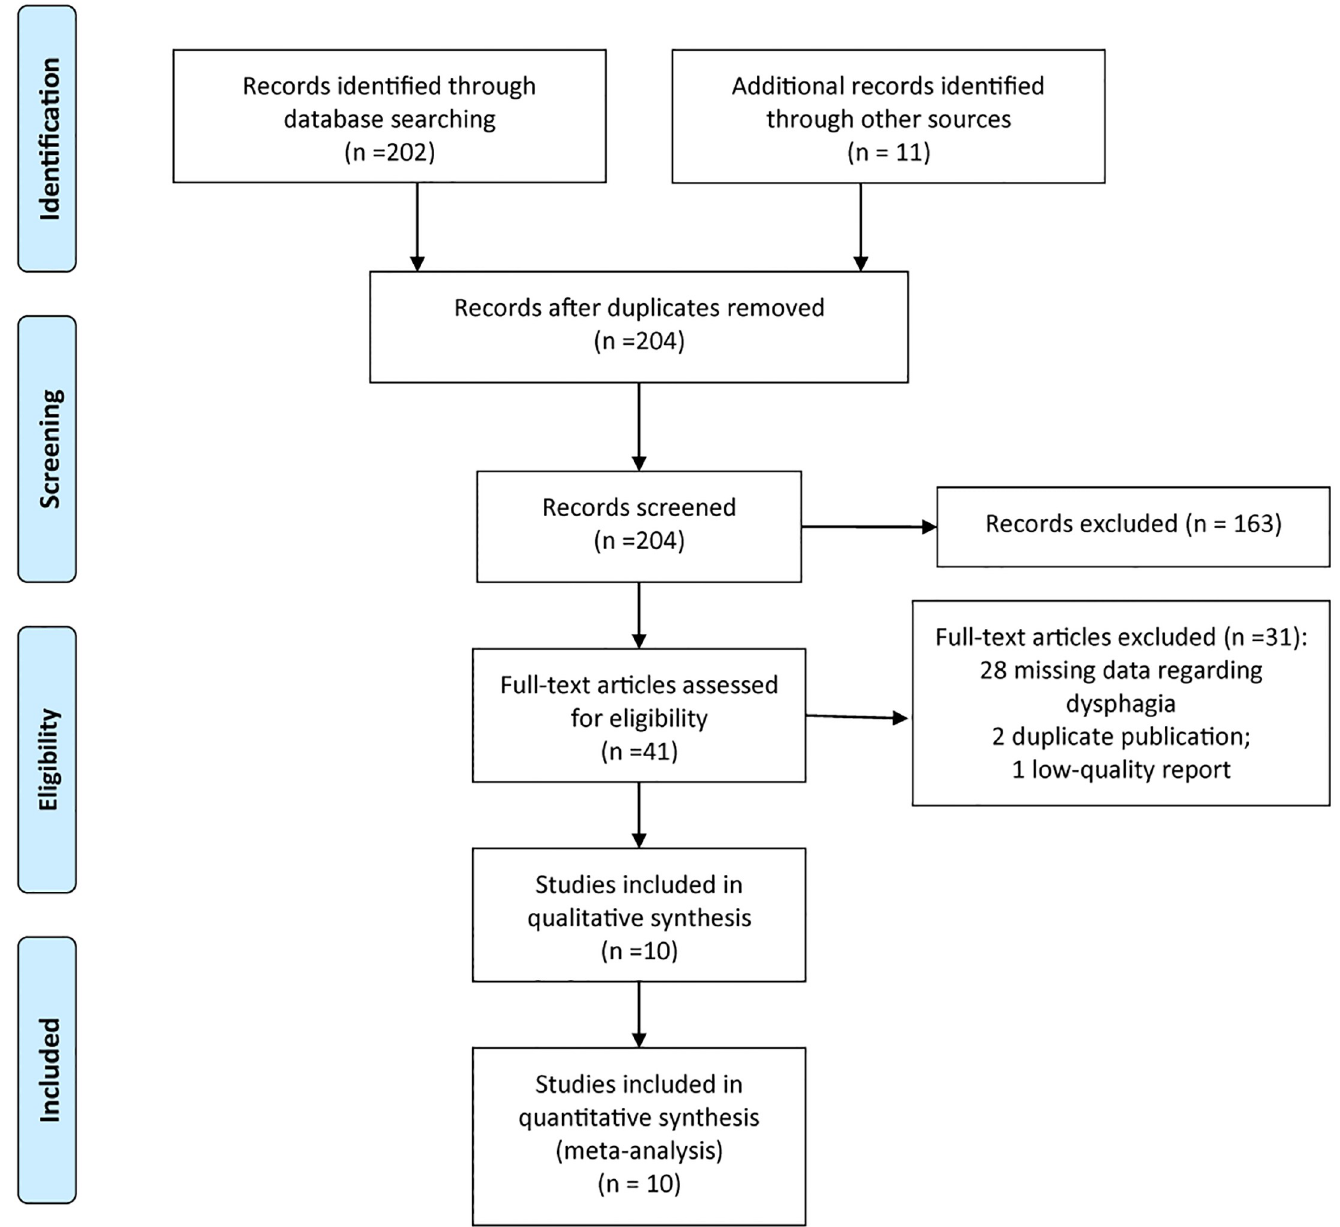
Fig 1. The flow chart of study